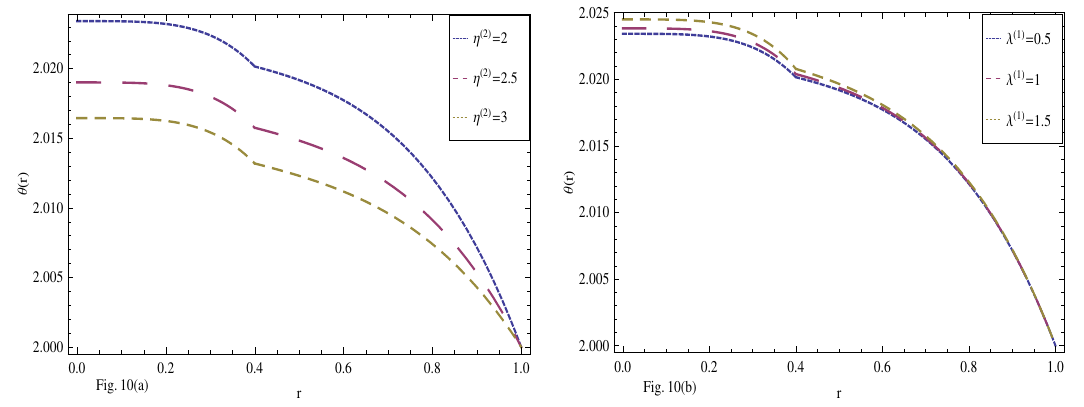
Figure 10. Effect of ( a ) η ( 2 ) and ( b ) λ ( 1 ) on the temperatures of the two fluids.